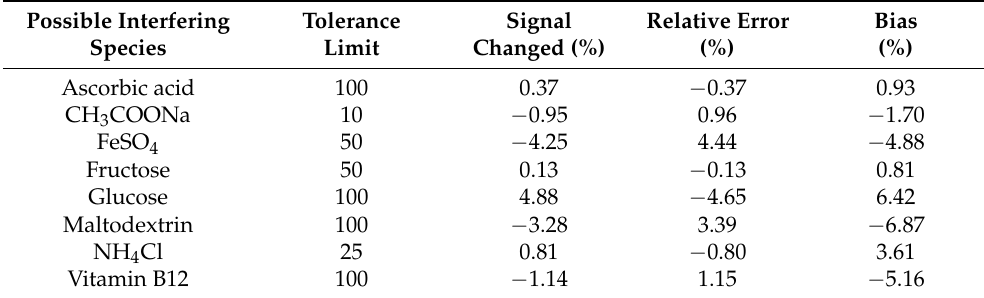
Table 2. The influence of possible interfering species on the detection of 1.0 × 10 − 9 thiamine ( n = 6) using the PIX/AuNPsnGr sensor.